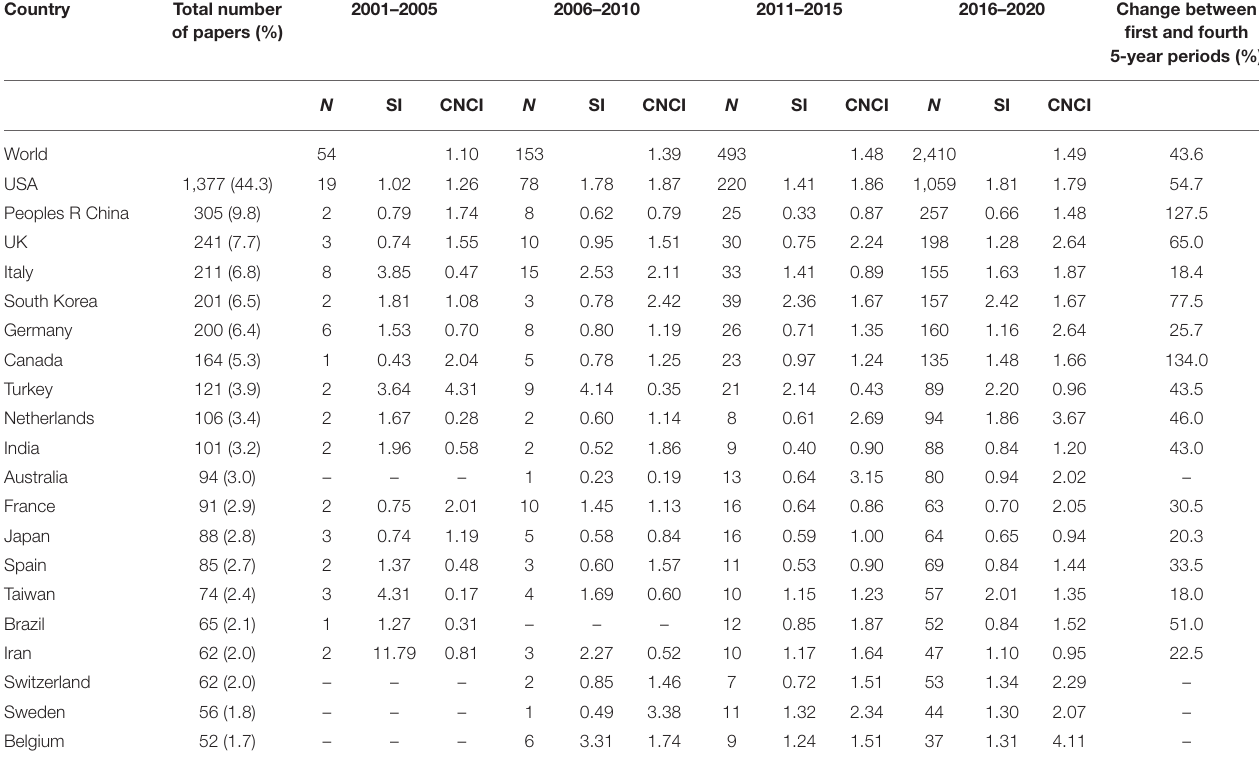
TABLE 1 | The 20 countries contributing the most gender-related articles in medical artificial intelligence. Country